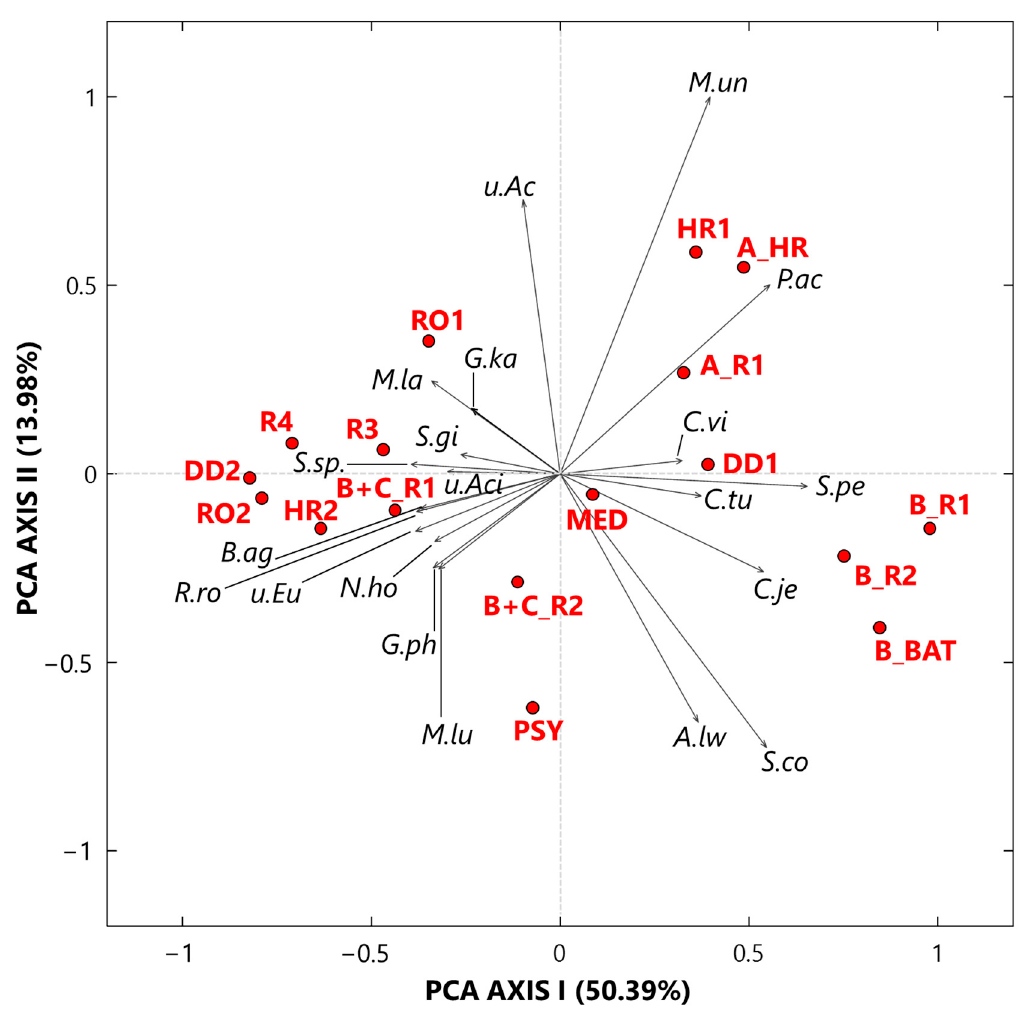
Figure 6. Two-dimensional SVD-PCA of the CLR-transformed values for the 20 selected bacterial species by the score (red dots) and the loading (black arrows) plot. The percentages of the total variance explained by the first and second principal components are also reported. Legend: M.un